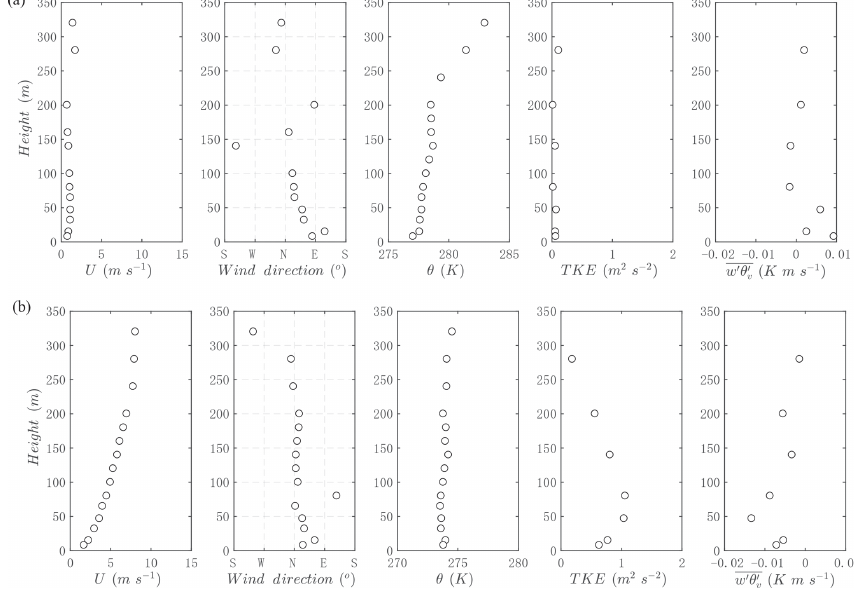
Figure 8. Vertical profiles of wind speed ( U ), wind direction (WD), potential temperature ( θ ), turbulent kinetic energy (TKE) and sensible heat flux ( w (cid:48) θ (cid:48) v ) at 23:20LT on 19 December 2016 (a) , 22 December 2016 (b)